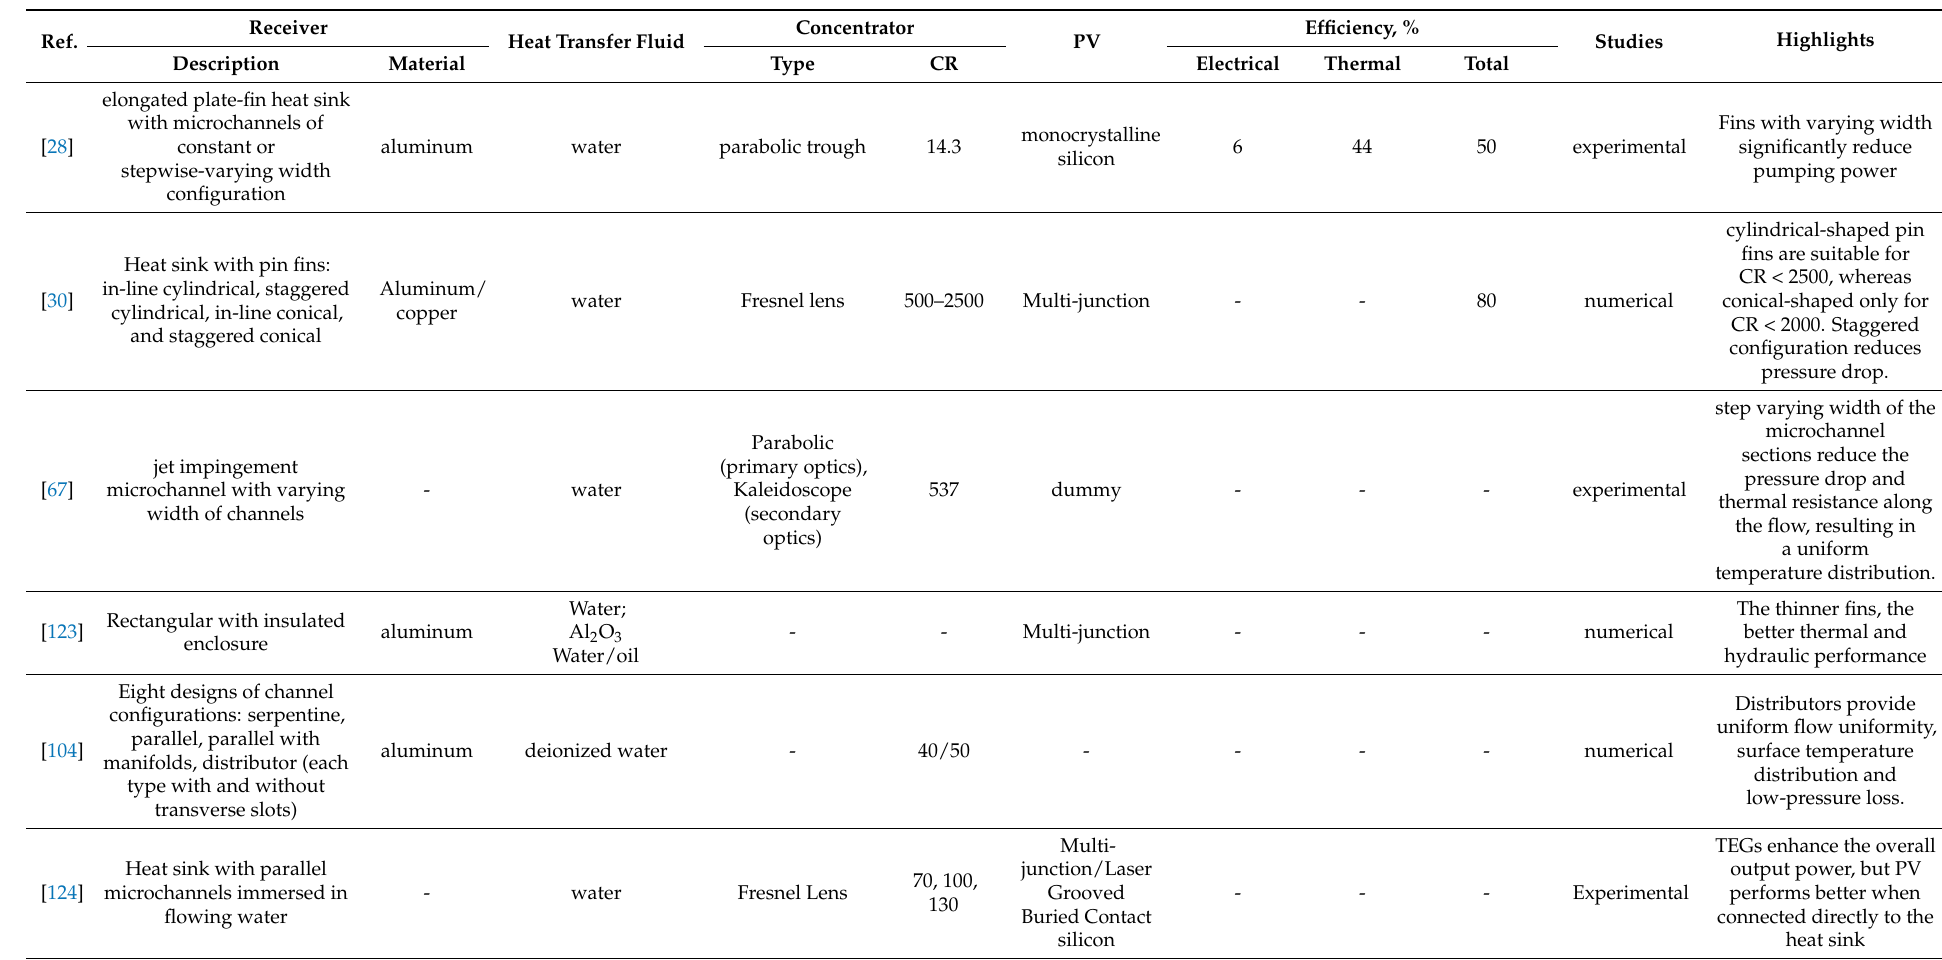
Table 5. Summary of discussed heat receivers with micro-scale